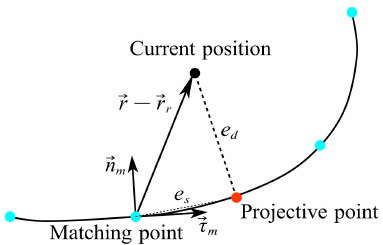
Figure 12. Relationship between the matching point and reference